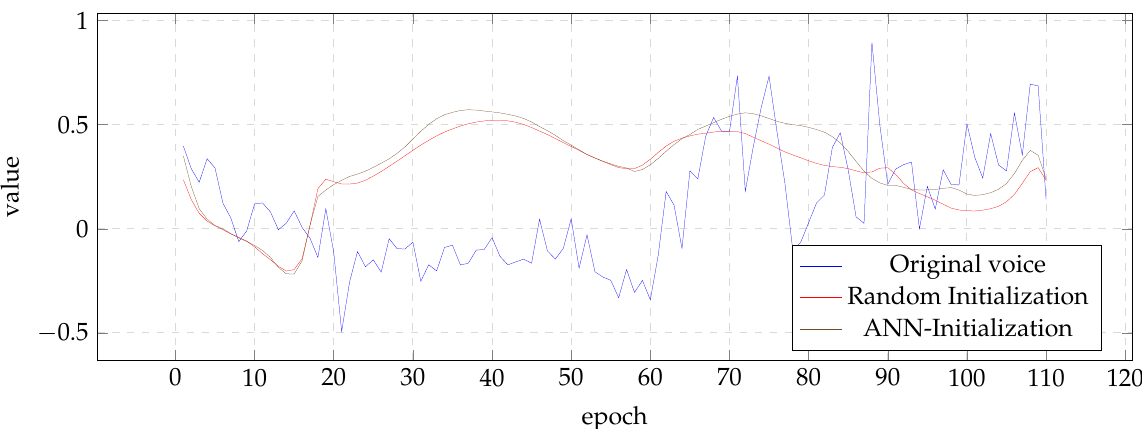
Figure 7. Sample contour of the fifth MFCC for the SLT